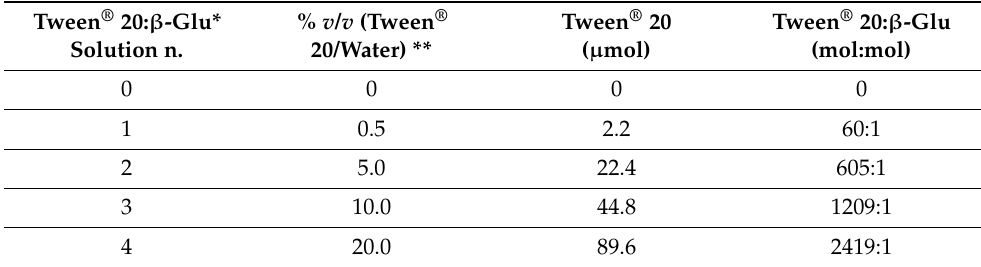
Table 1. Tween ® 20: β -Glucosidase